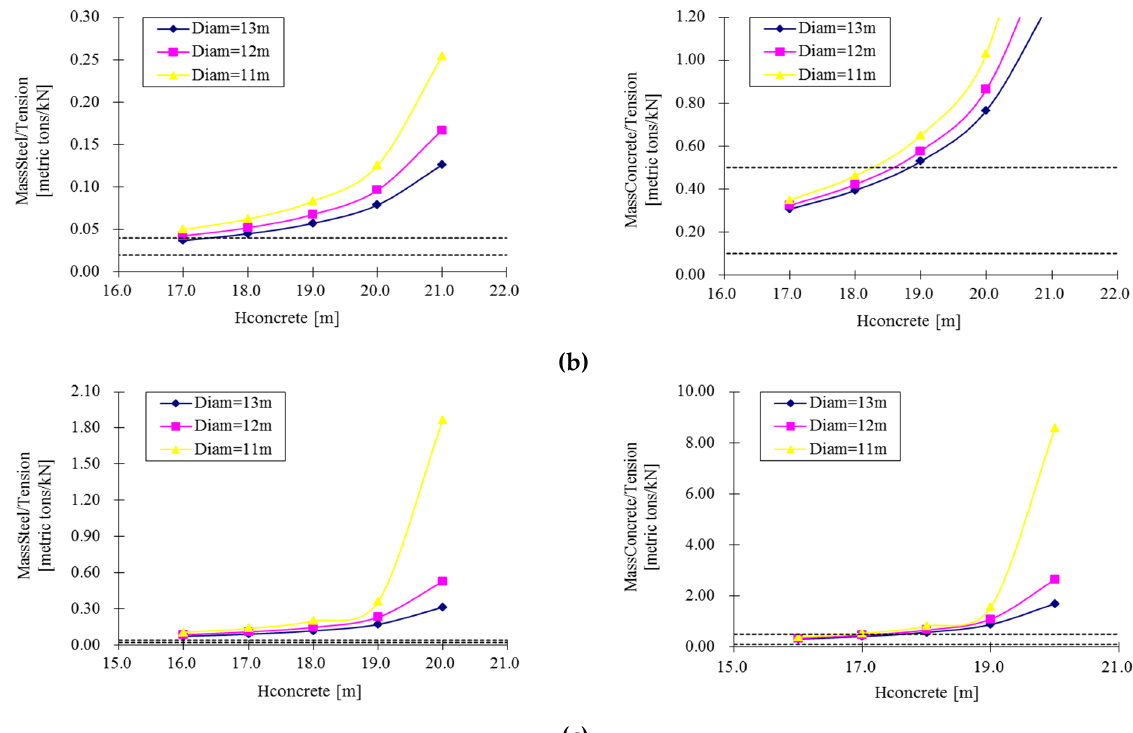
Figure 6. Optimized mass property ratio for three cases with SWT = ( a ) 0.015 m; ( b ) 0.0253 m and ( c ) 0.045 m. The region between the black dash lines represents the optimized cost regions. Table 6. Design result for concrete ballast height from step 1.